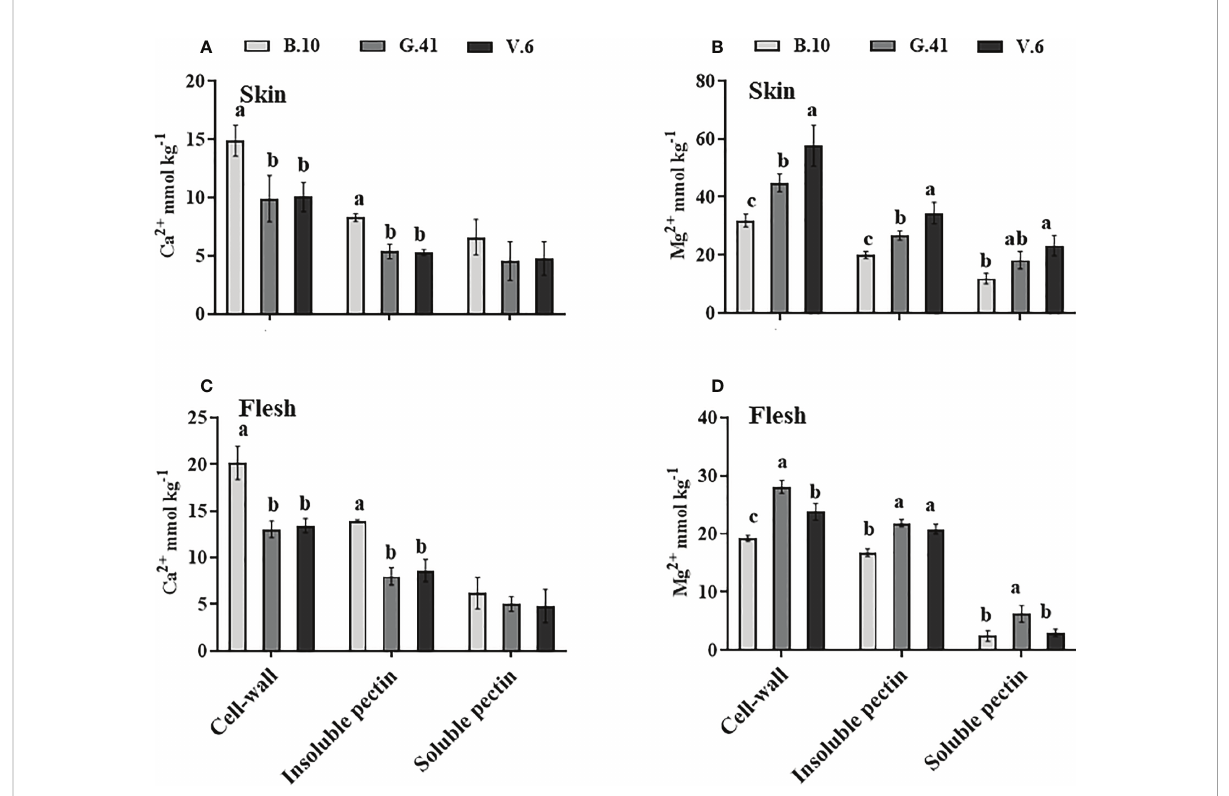
FIGURE 7 Rootstock effects on the Ca 2+ and Mg 2+ partitioning in the cell-wall materials of skin and fl esh tissues of ‘ Honeycrisp ’ apples. (A, C) Ca 2+ concentration in cell-wall, insoluble pectin, and soluble pectin of apples ’ skin and fl esh tissues, (B, D) Mg 2+ concentration in cell-wall, insoluble pectin, and soluble pectin of apples ’ skin and fl esh tissues. Means not sharing any letter are signi fi cantly different at P < 0.05, according to Tukey ’ s HSD